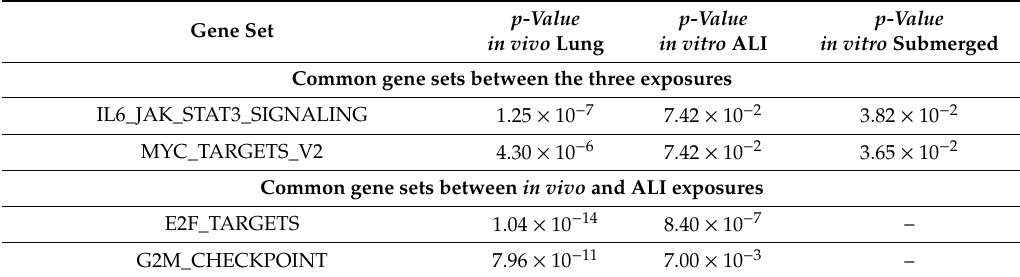
Table 3. Gene set enrichment analysis (GSEA) functional annotation of di ff erentially expressed genes (DEG) in the three